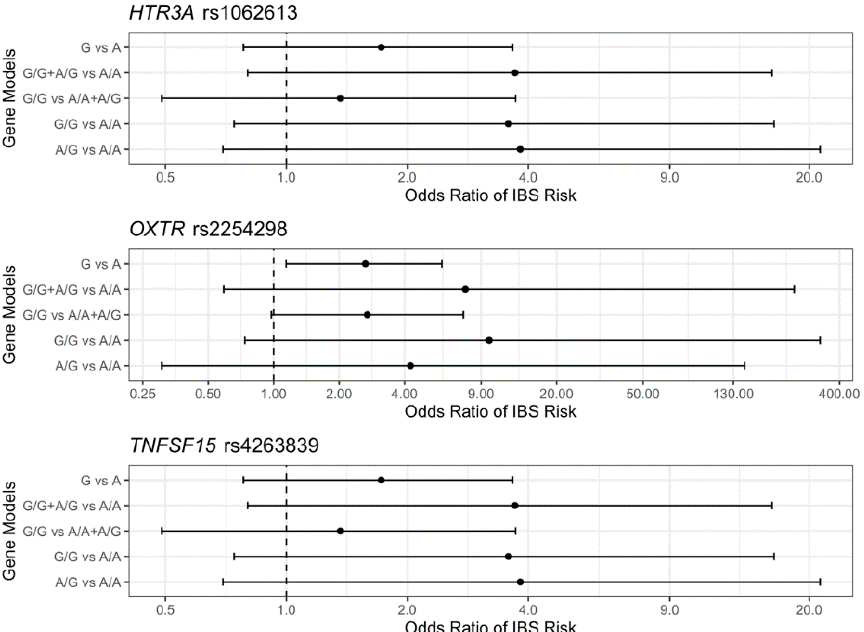
Figure 1. Mid-p estimates and 95% confidence intervals of odds ratio (ORs) of irritable bowel syndrome (IBS) risk for the gene models in (single nucleotide polymorphisms) SNPs of hydroxy tryptamine receptor 3A encoding the 5-HT3 receptor ( HTR3A) rs1062613, oxytocin receptor ( OXTR) rs2254298, and tumor necrosis factor superfamily member 15 ( TNFSF15) rs4263839.